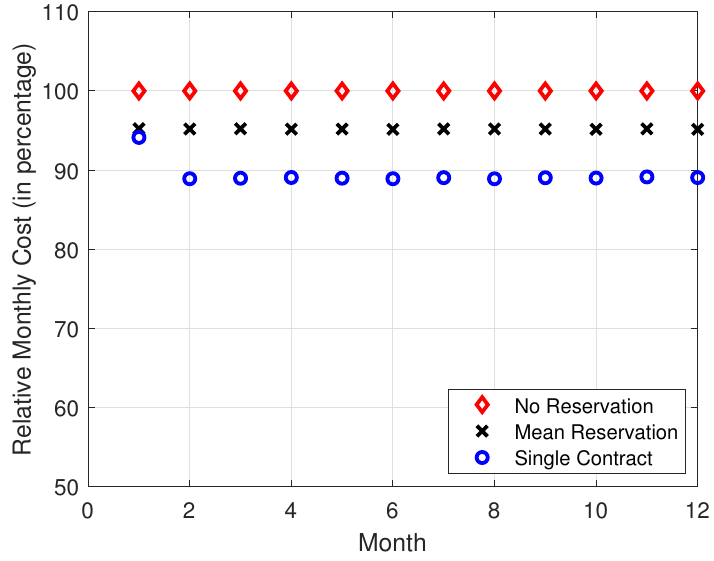
Figure 5. Relative monthly cost vs. month. The demand traffic is modeled as an exponential stochastic process with mean = 4000 VMs. Monthly cost (in